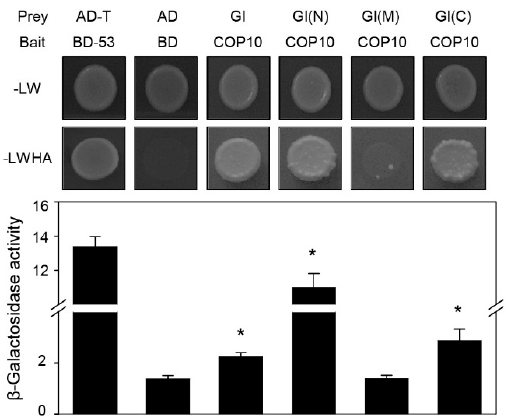
Figure 3. COP10 directly interacts with GI in a yeast two-hybrid assay. The bait was full-length COP10. For prey, GI was divided into three pieces: N-terminal (N; aa 1–507), middle (M; aa 401–907), and C-terminal (C; aa 801–1173). pGBKT7-53 (BD-53) and pGADT7-T were used as a positive